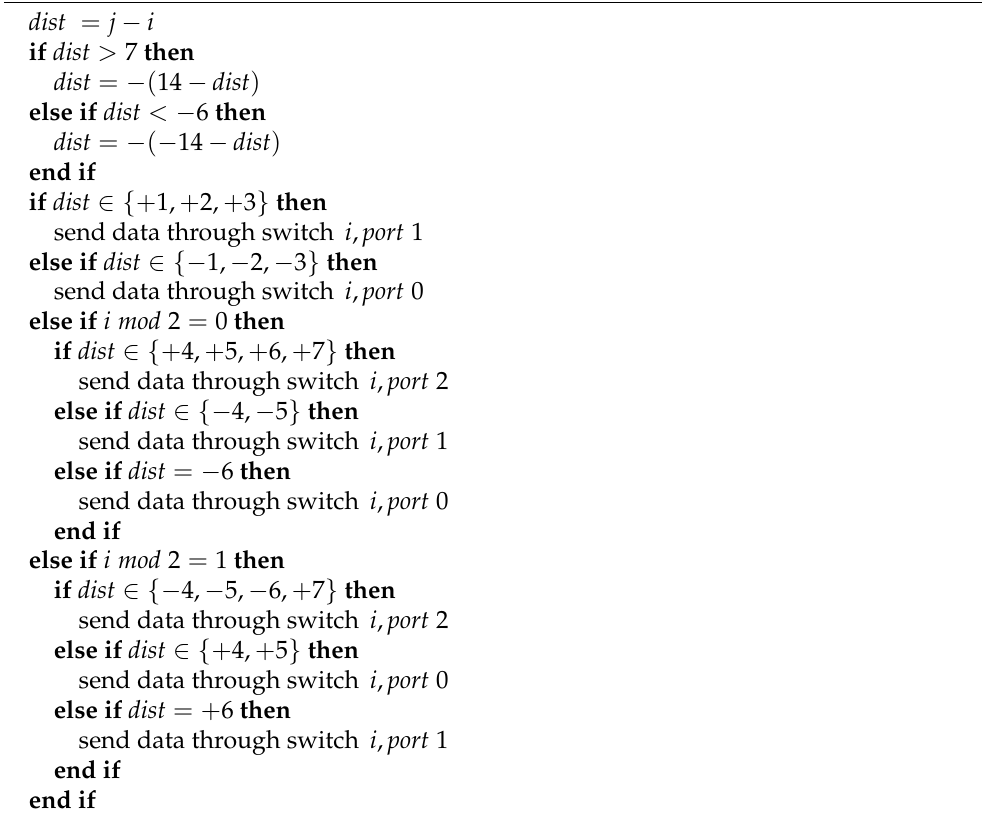
Algorithm 2: Moving from node i to node j in a Heawood